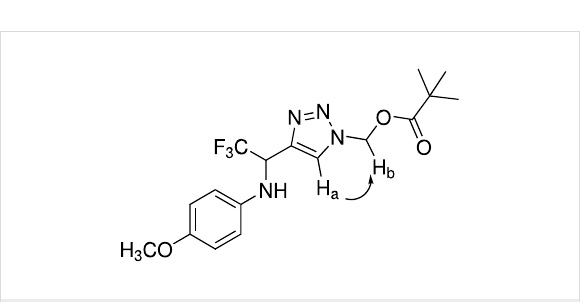
Figure 1: Experimentally found NOE correlation for compound 2c